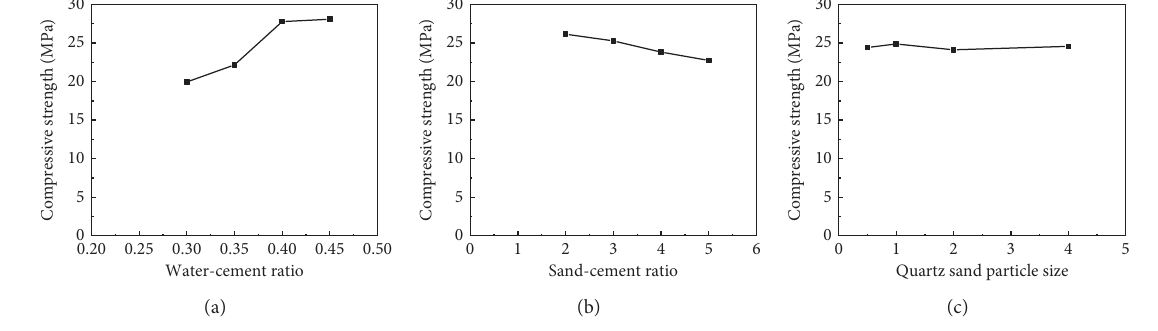
Figure 3: Sensitivity analysis of compressive strength.